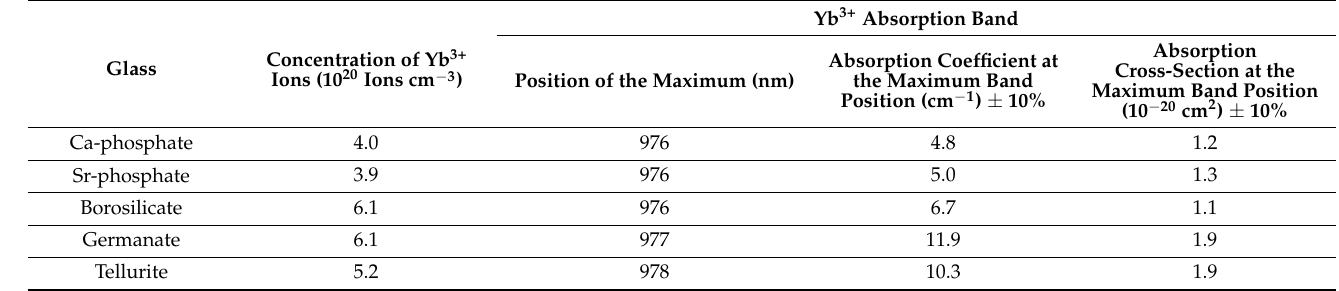
Table 2. The absorption coefficient and cross section at ~976 nm of the investigated